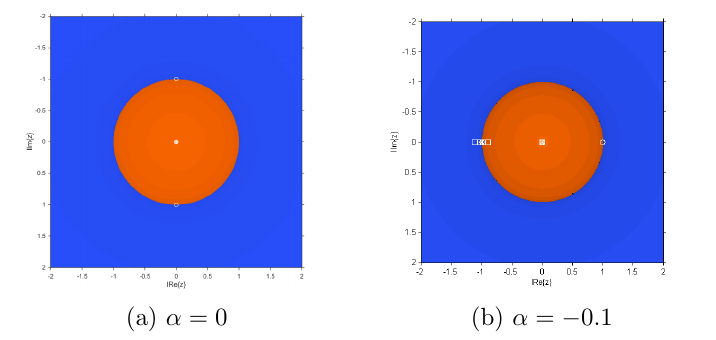
Figure 8. Dynamical planes of operator G ( z,α ) for α ≈